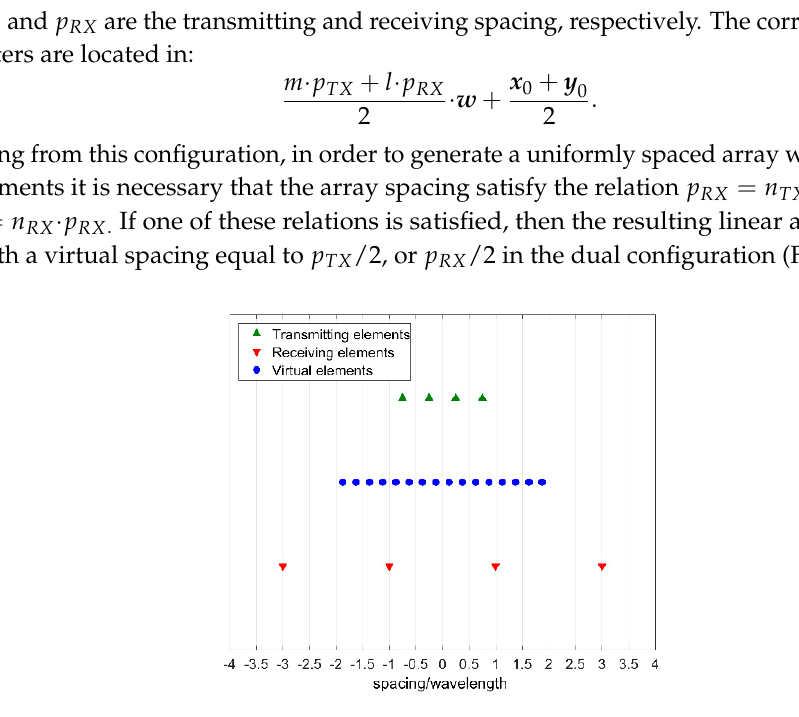
Figure 2. 16 elements MIMO uniform linear array (in blue) obtained from 4 elements transmitting linear array and 4 elements receiving linear array.